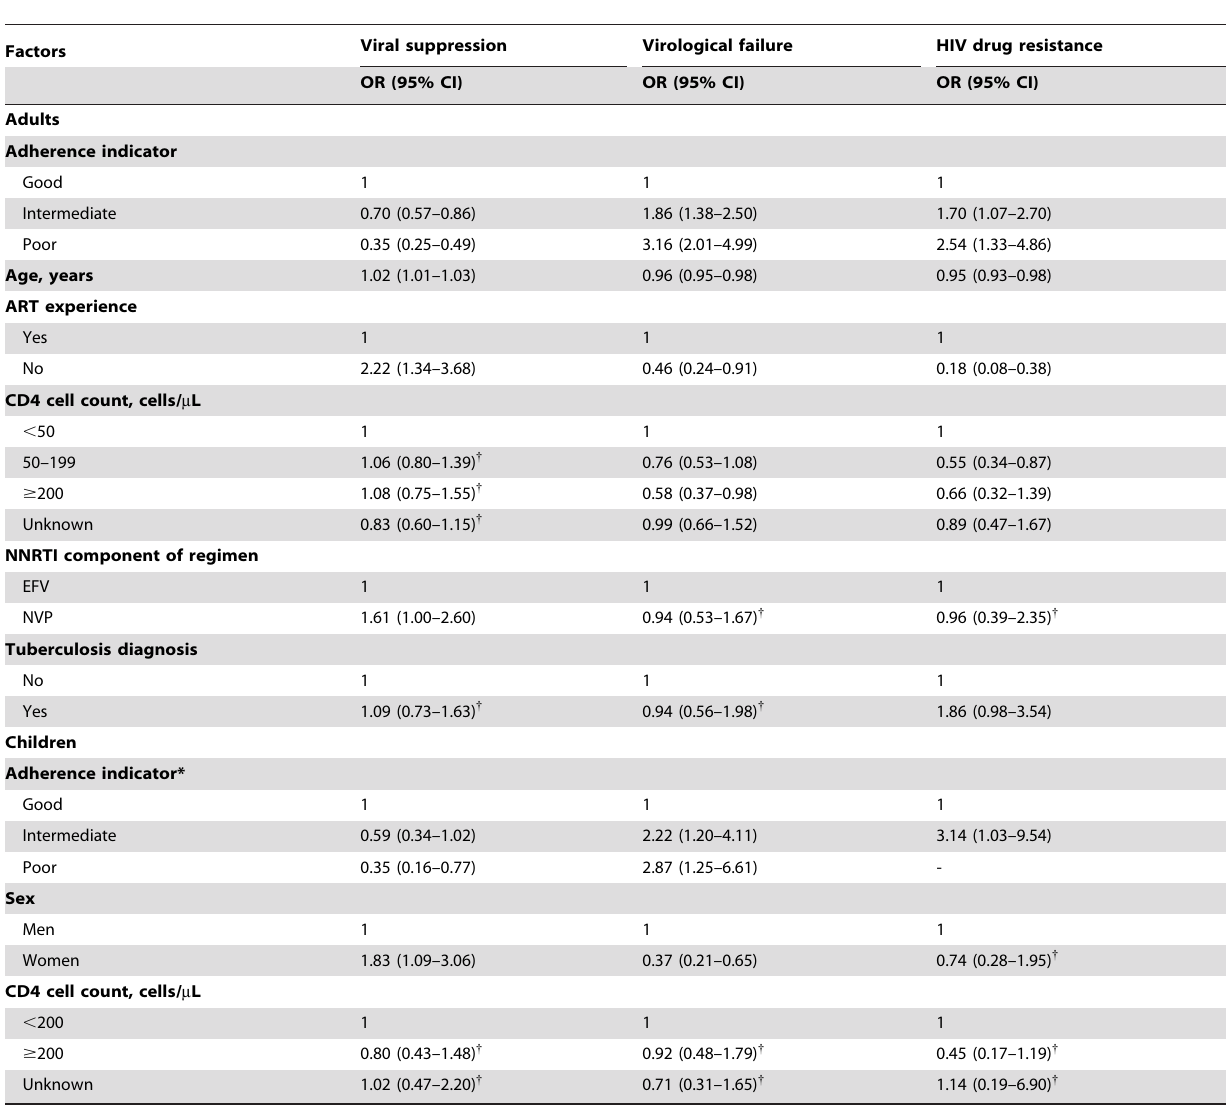
Table 2. Multivariate random-intercept logistic regressions of experiencing viral load suppression, virological failure and HIV drug resistance for adults and